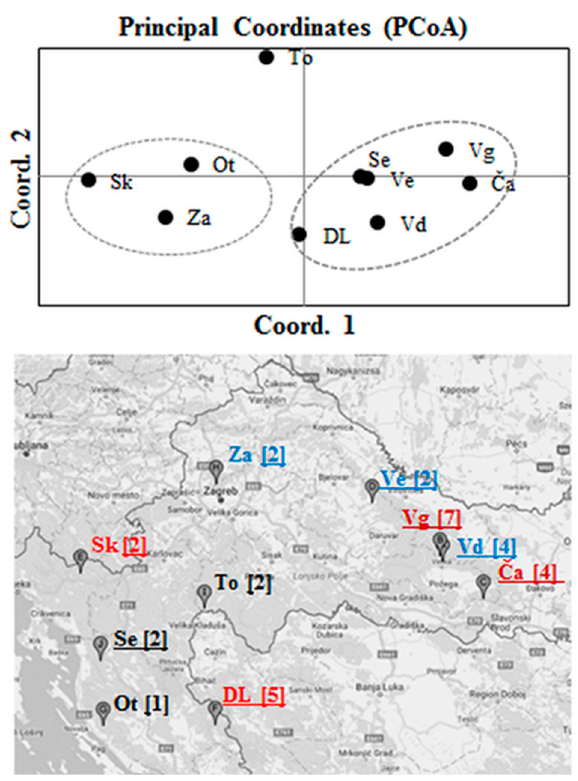
Figure 4. PCA based on Nei’s genetic distances among populations. Alleles per locus and population were used for the analysis. Dashed lines represent clusters determined by Nei’s genetic distances (Table S7). The map below the PCA plot shows the origins of the Croatian beech ecotypes. Underlined ecotypes belong to the cluster formed on the right side of the PCA plot. The remaining ecotypes formed a cluster on the left site of the PCA plot. Only To did not cluster with any of the other ecotypes. Ecotypes shown in dark red = P-rich; ecotypes shown in red = moderately P-rich; ecotypes shown in blue = moderately P-poor; ecotypes shown in black = P-poor (Table S1b). Numbers in brackets indicate significant fold changes (Table 6).